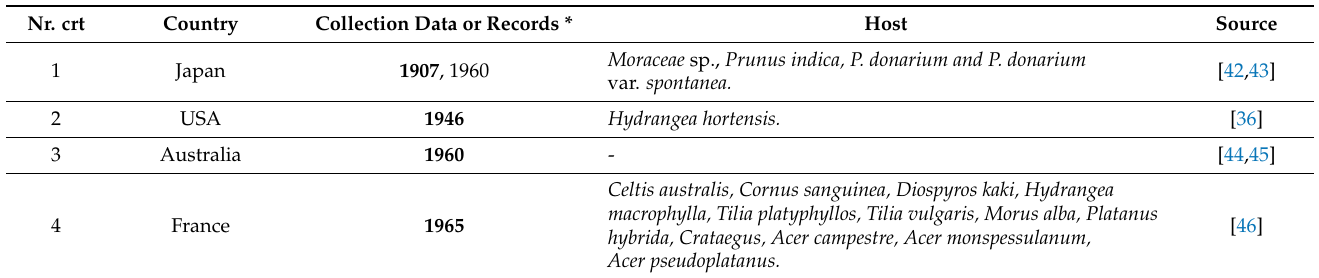
Table 2. Historical records of P. hydrangeae and the chronological infestation